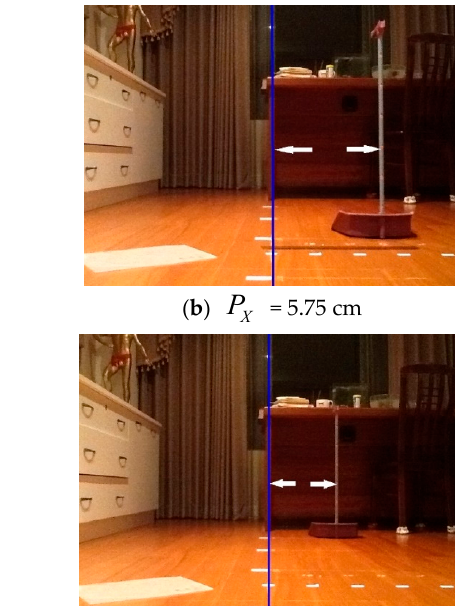
Table 1. Results of focal length f measurement ( X Q = 36 cm).